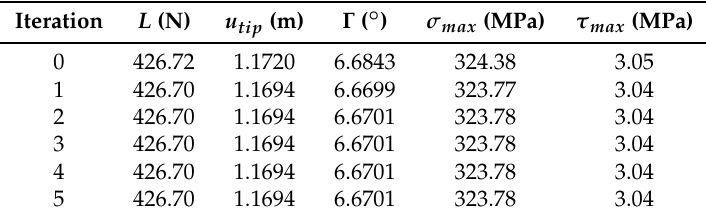
Table 6. Results of an example FSI simulation.